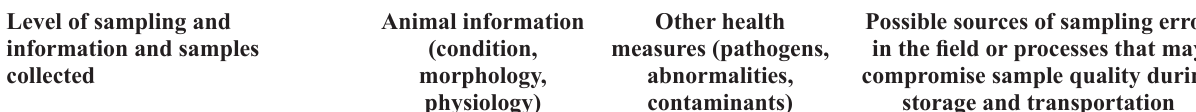
Table 1. Levels of sampling done by CARMA with the samples and data gathered (indicators) at each level, the information that each indicator provides on animal body condition, disease, or contaminants, and observed or anticipated sources of error or sample quality compromise associated with collection or transport of the data